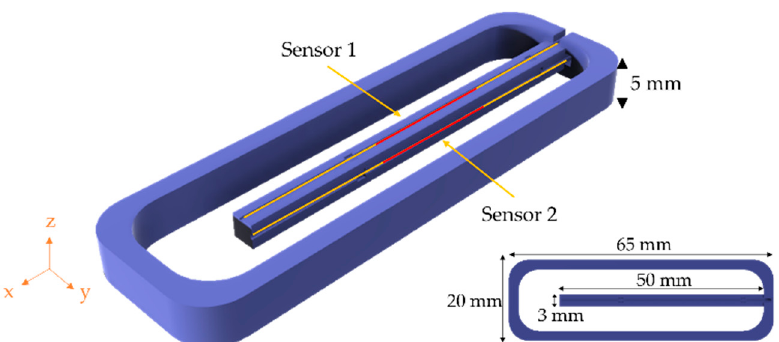
Figure 1. Schematic view of the designed cantilever structure with a square cross-section and the respective fiber position. In the inset, the relevant dimensions are annotated. The line in yellow rep- resents the optical fiber and the red represents the position of the FBGs.